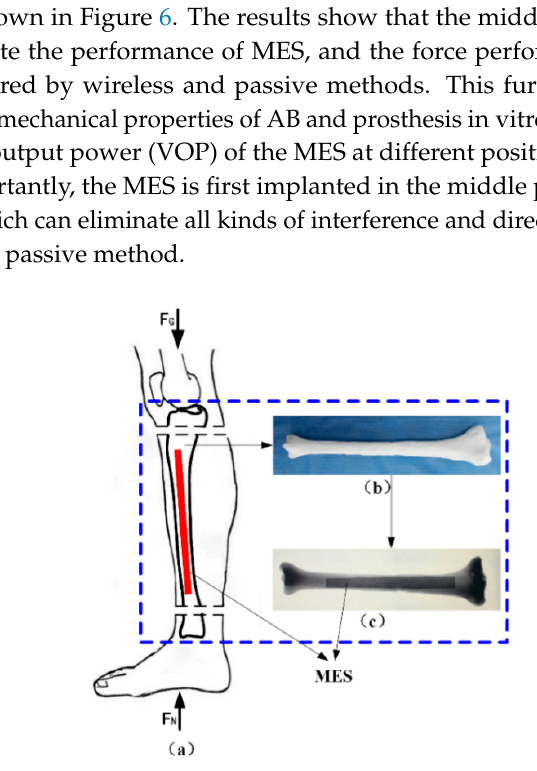
Figure 6. Application of the AB (artificial bone). ( a ) Human shank model with AB, ( b ) 3D printing AB and ( c ) X-ray picture.